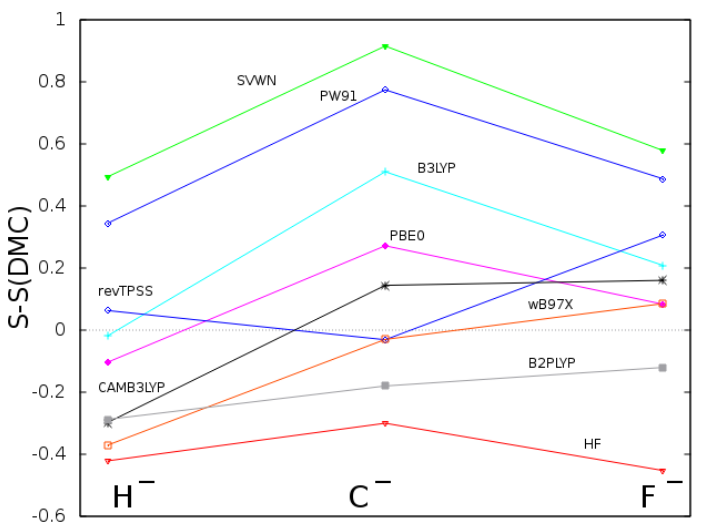
Figure 1. Deviation from DMC of Shannon entropy computed for the three anions, H − , C − , and F − , using eight functionals representative of the Jacob’s ladder and